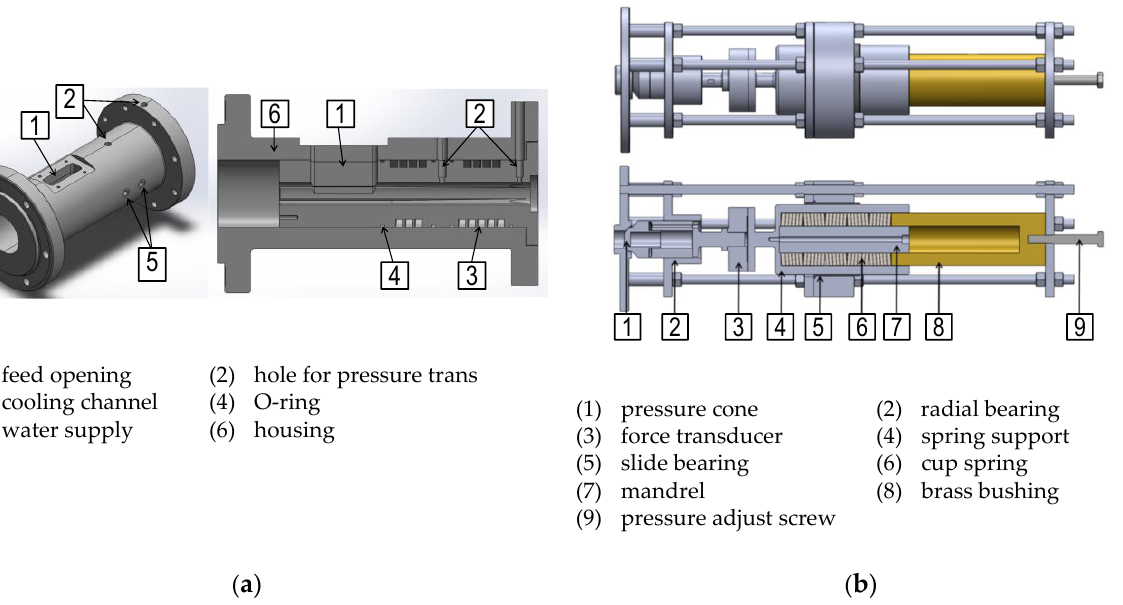
Figure 13. ( a ) Isometric and sectional view of the shortened filler housing including grooved barrel; ( b ) side and sectional view of the backpressure device.